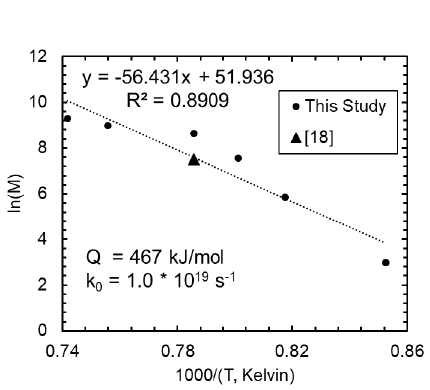
Figure 4. Determination of the activation energy (Q) for grain growth, a Q value of 467 kJ/mol is calculated for this alloy.